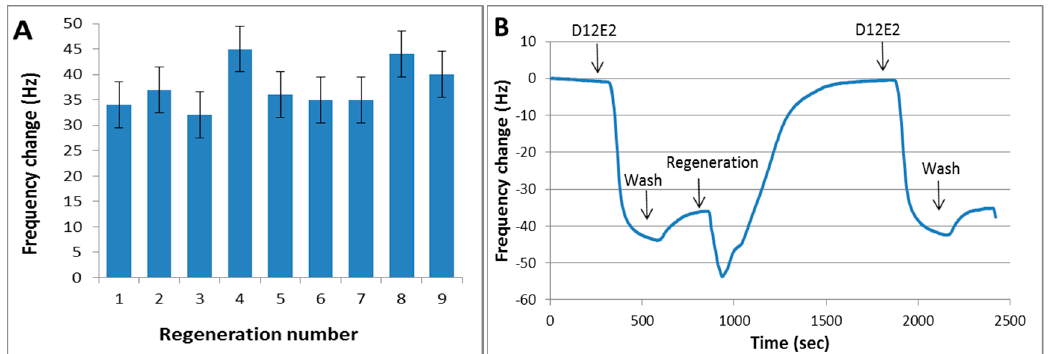
Figure 5. Regeneration of AF immobilized sensor surface. ( A ) Sequential regeneration of the sensor surface with 50 mM NaOH and 1% SDS. Graph shows sensor response as frequency change upon delivery of 0.1 mg/mL MAM-D12E2 antibody after each regeneration; ( B ) Sensogram showing a typical regeneration cycle with MAM-D12E2 antibody.